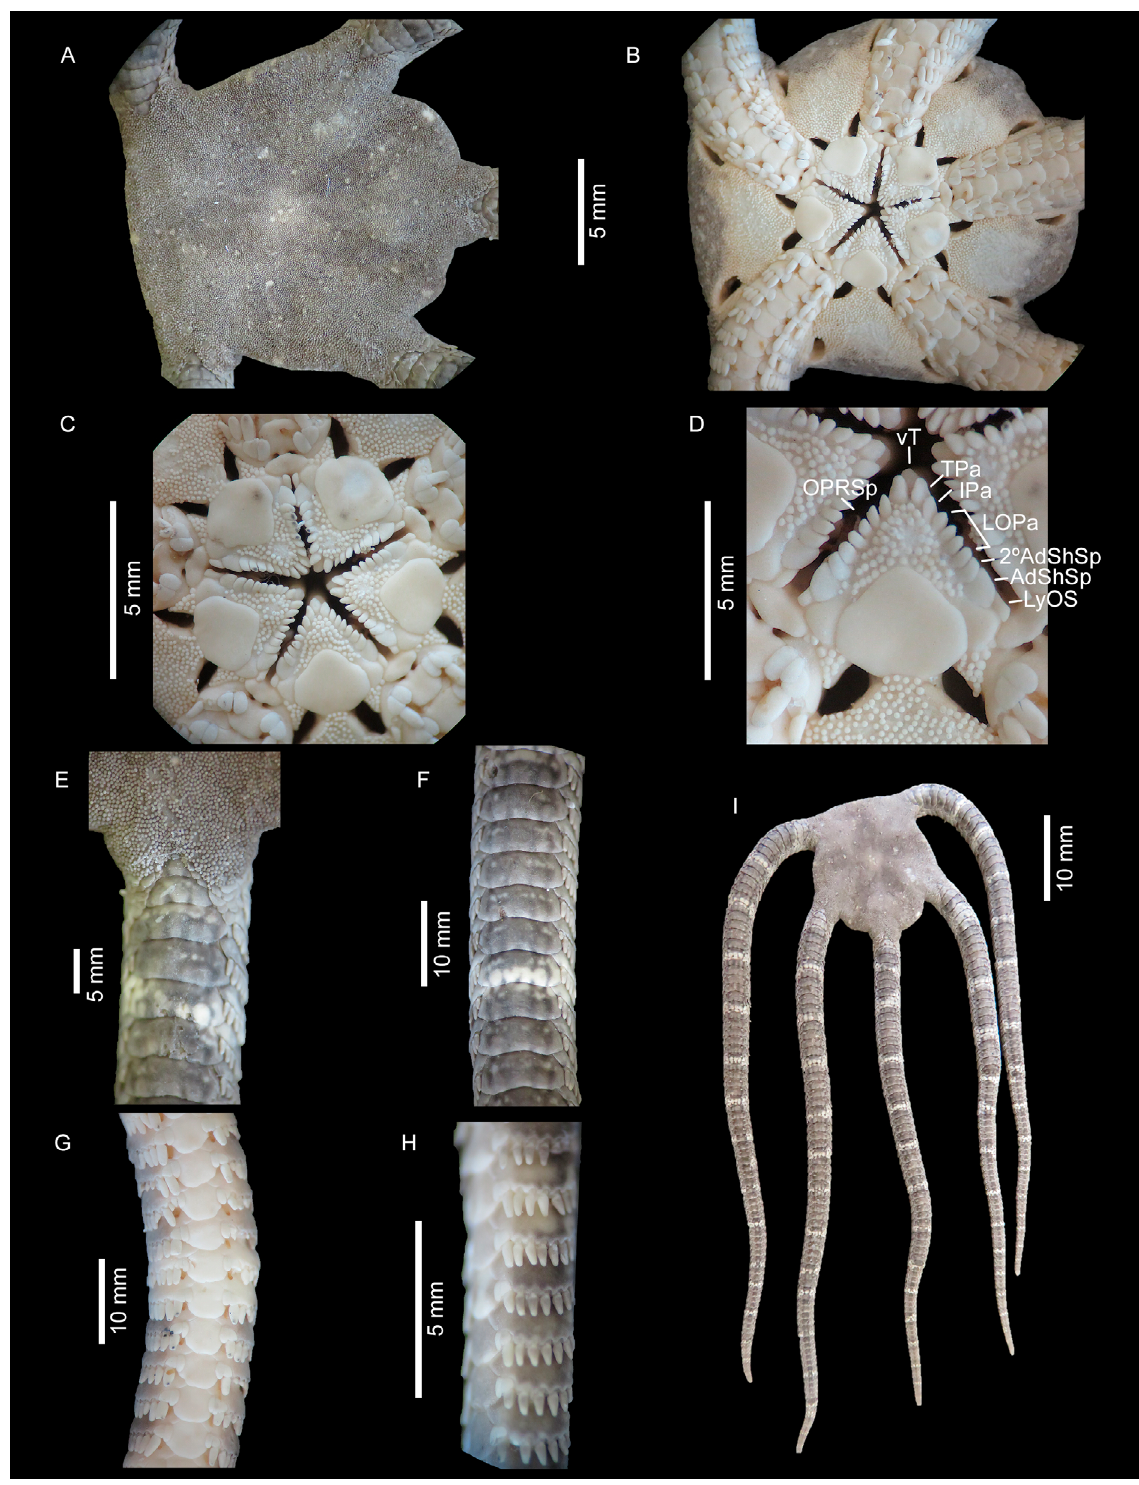
Fig. 1. Ophioderma hendleri sp. nov., holotype (ICML-UNAM 18315, DD = 14.8 mm). A . Dorsal disc. B . Ventral disc. C . Mouth. D . Structures of a jaw (according to Hendler 2018). E . Basal dorsal arm. F . Dorsal arm. G . Ventral arm. H . Lateral arm plates and arm spines. I . Dorsal view. See Material and methods for